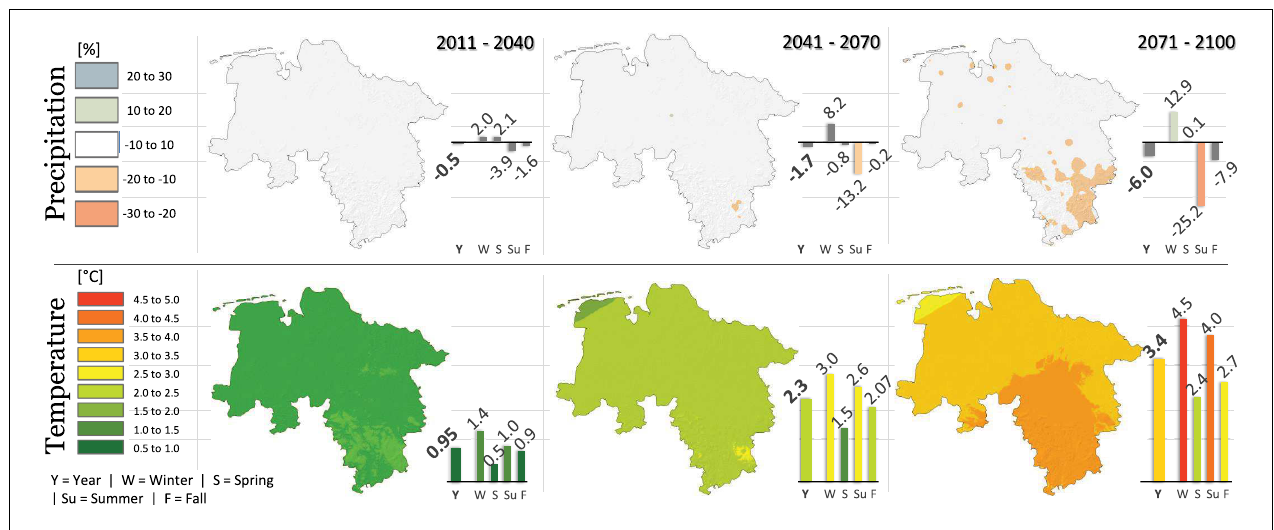
FIGURE 4 | Climate Change in Niedersachsen. Maps depict the mean change in temperature or precipitation respectively for the given time period. Changes are relative to 1971–2000. Temperature differences are in degree centigrade, precipitation differences in